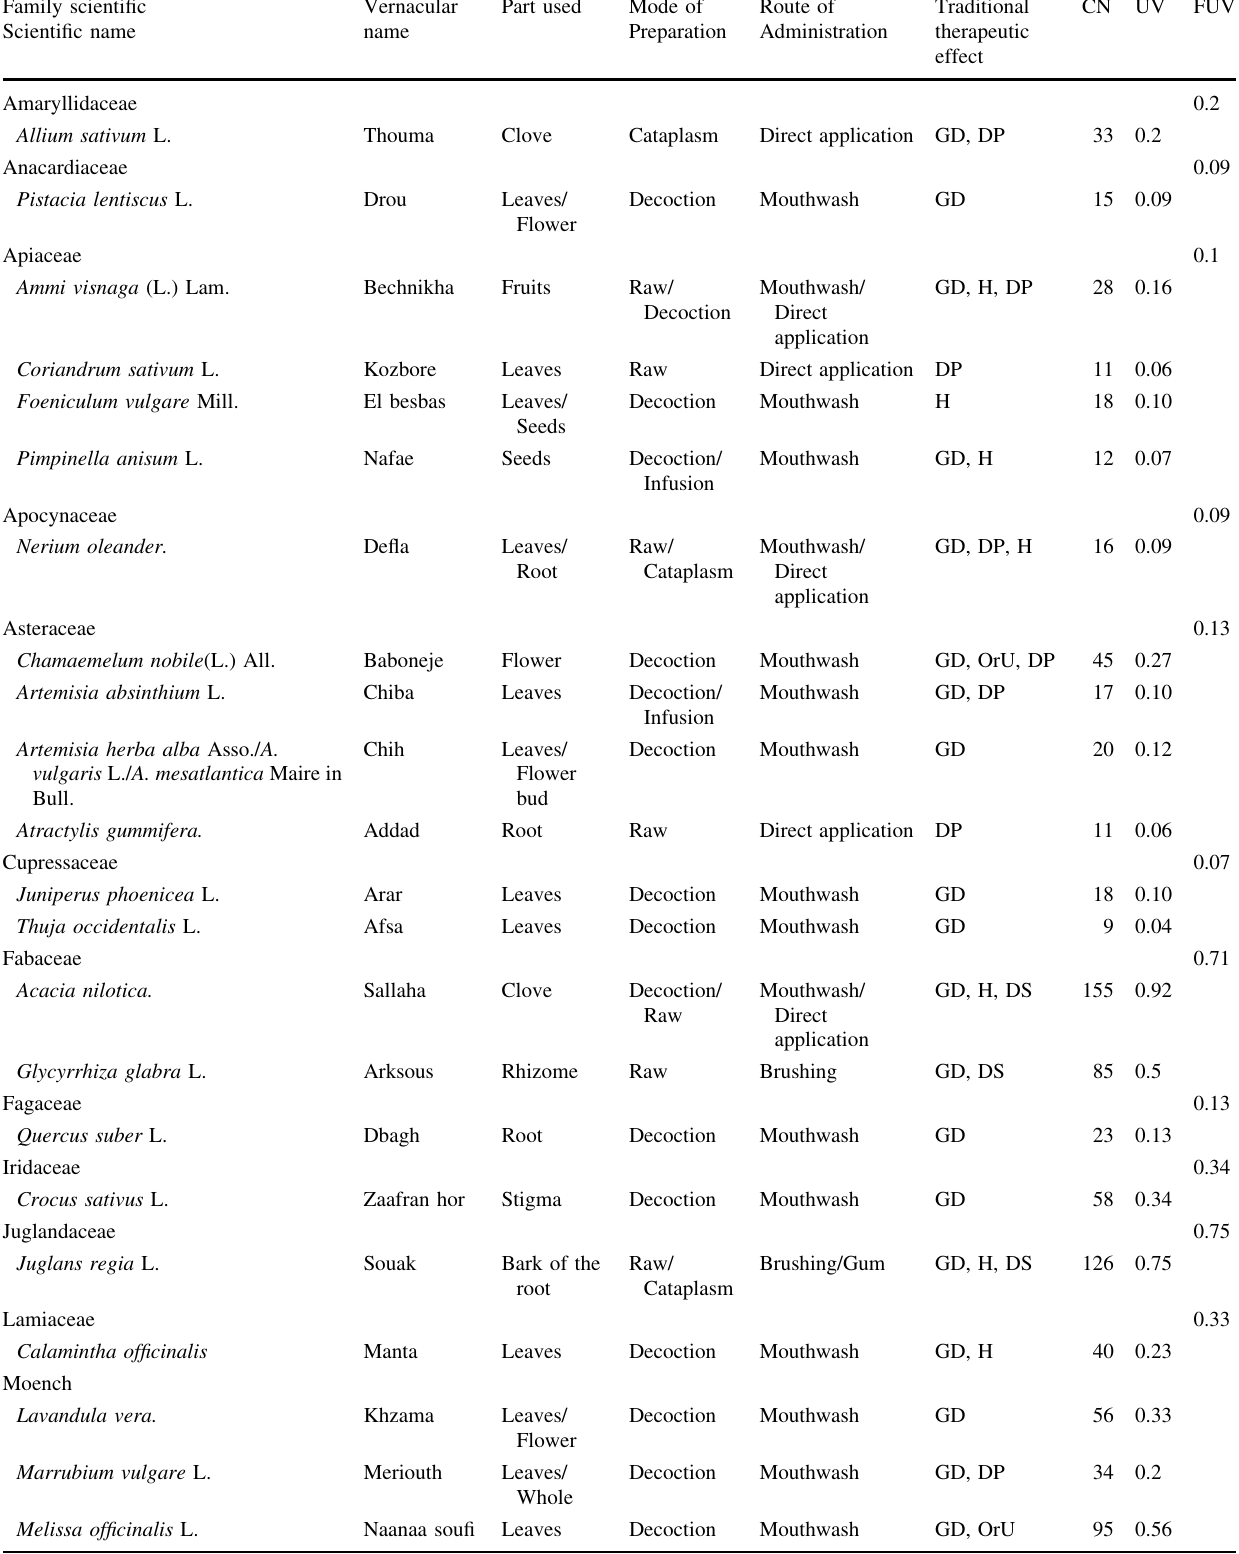
Table 3 List of Medicinal and aromatic plants used for the treatment of oral pathology prescribed by traditional